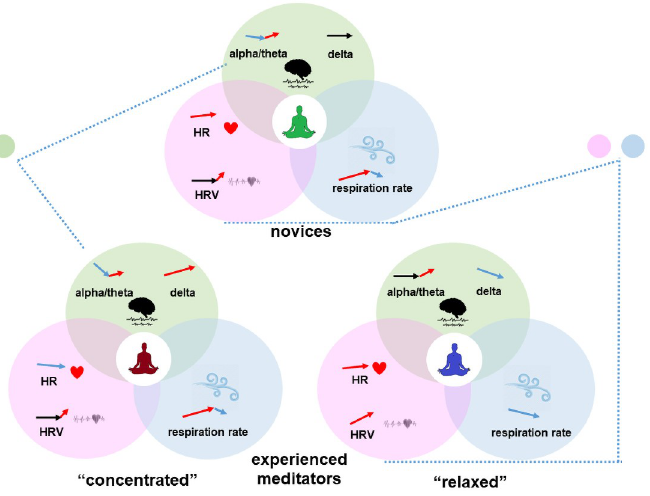
Fig 10. Visual summary of the obtained results. Arrows mark direction of changes of markers during meditation.